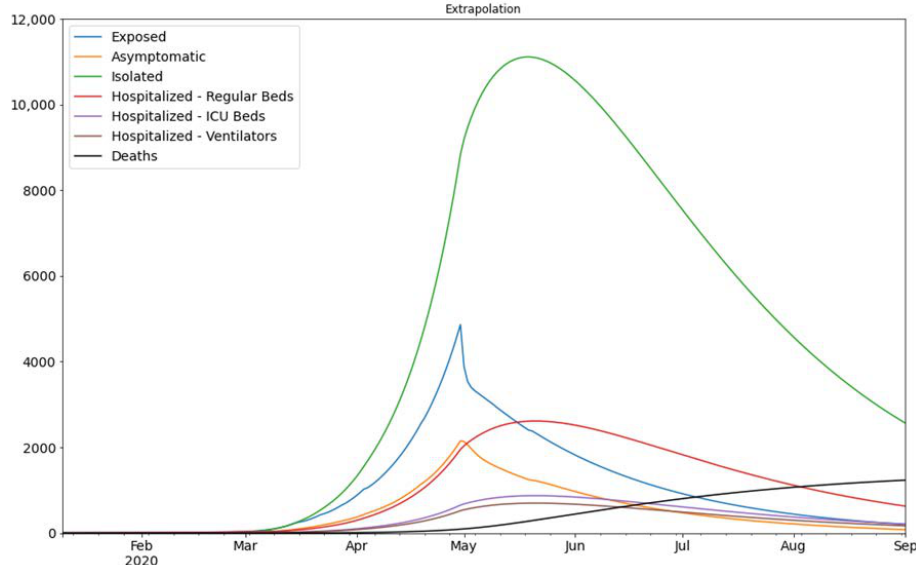
Figure 4. The extrapolation of the result of Figure 3. The assumed division of infected population is as follows: 30% of the Infected population would be asymptomatic, 55% mild cases, and 15% hospitalized (which are further divided into three sub-categories) according to Lauer et al. [9].